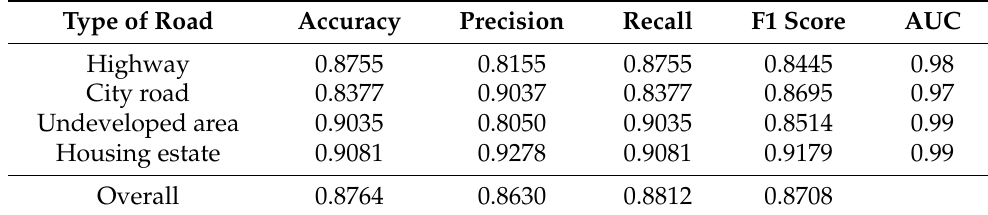
Table 4. Performance parameters for the test dataset.